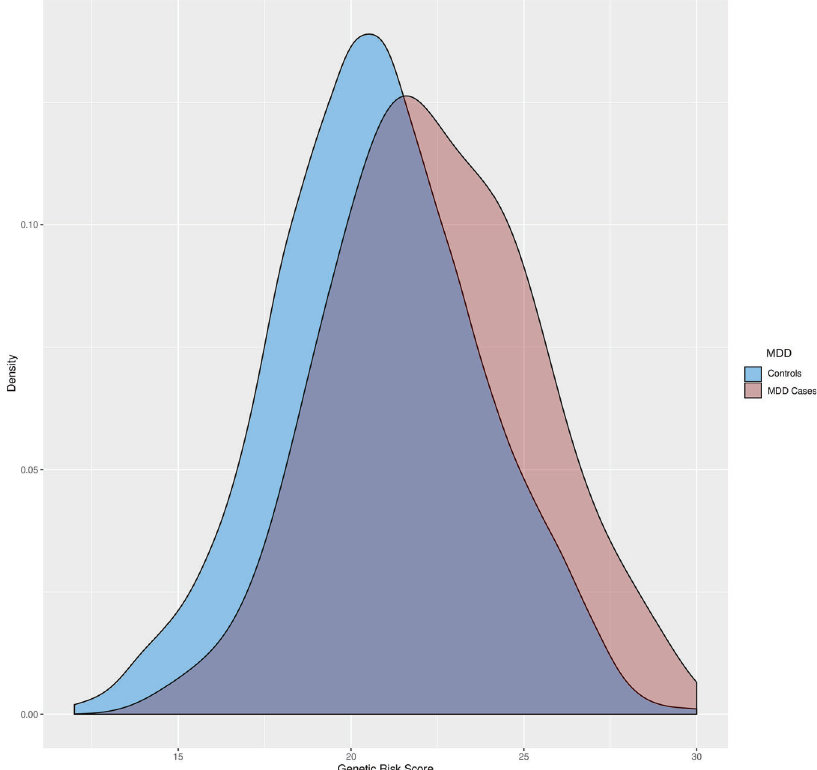
Fig. 2 Density distribution plot of the constructed GRS in our population. MDD major depressive